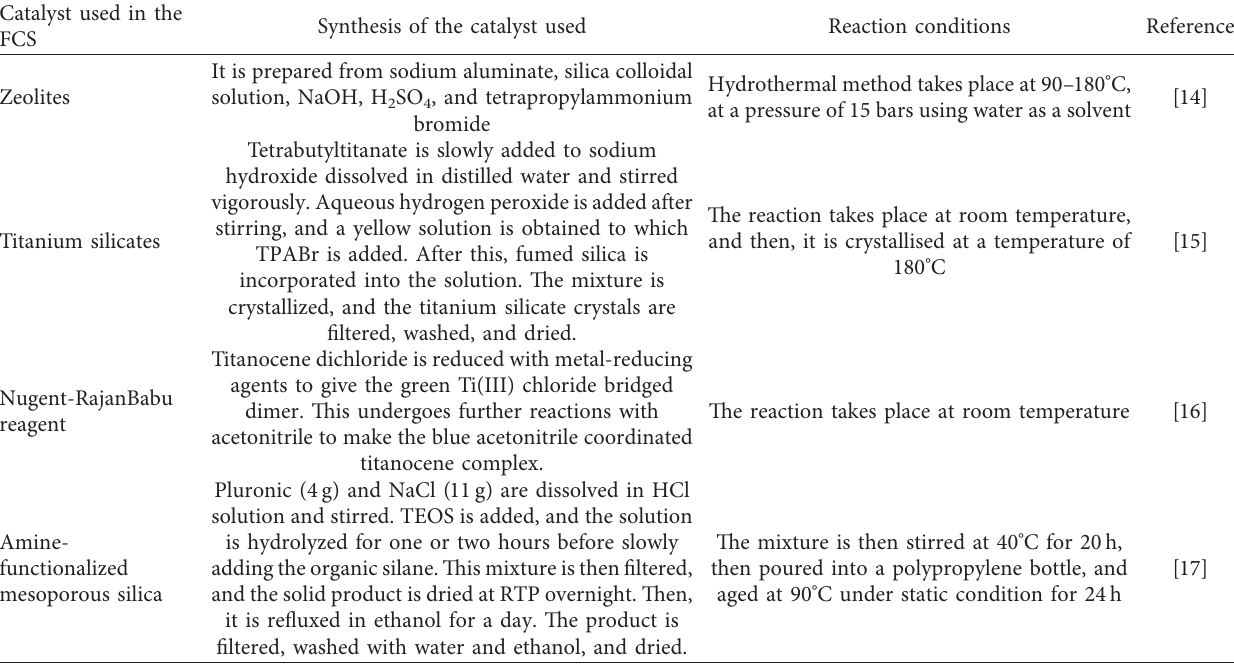
Table 2: Synthesis methods of some of the catalysts used in fine chemical synthesis.